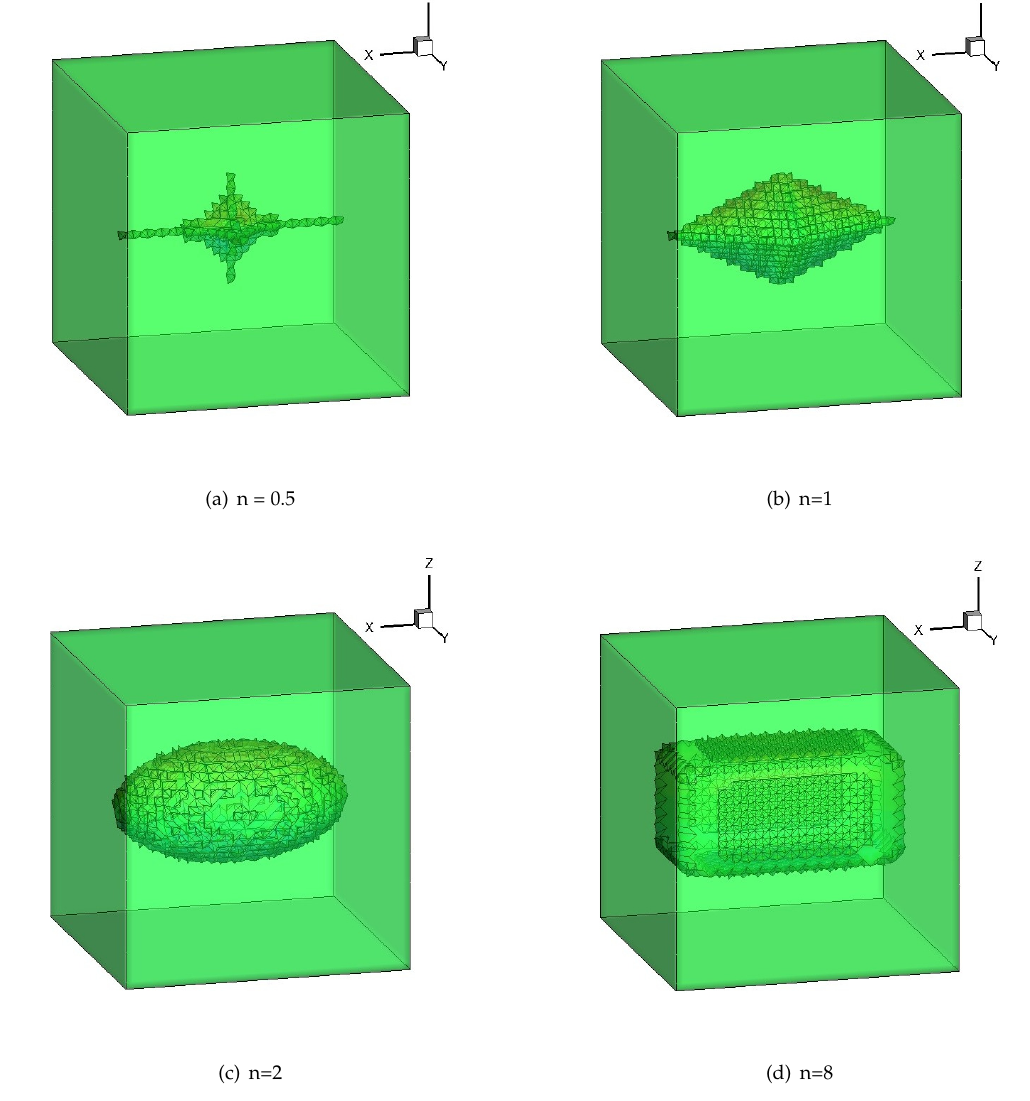
Figure 4. 3D images of a single pore generated with Equation (1) with different n s, made by 39 × 39 × 39 × 5 finite element model: ( a ) n = 0.5, ( b ) n = 1, ( c ) n = 2, ( d ) n =